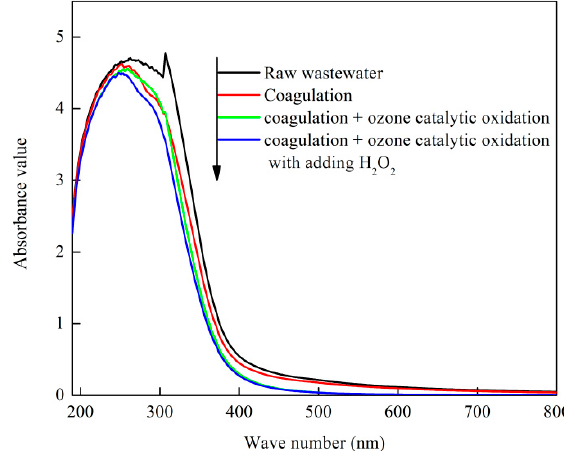
Figure 11. UV-visible spectra of effluent from different treatment processes.